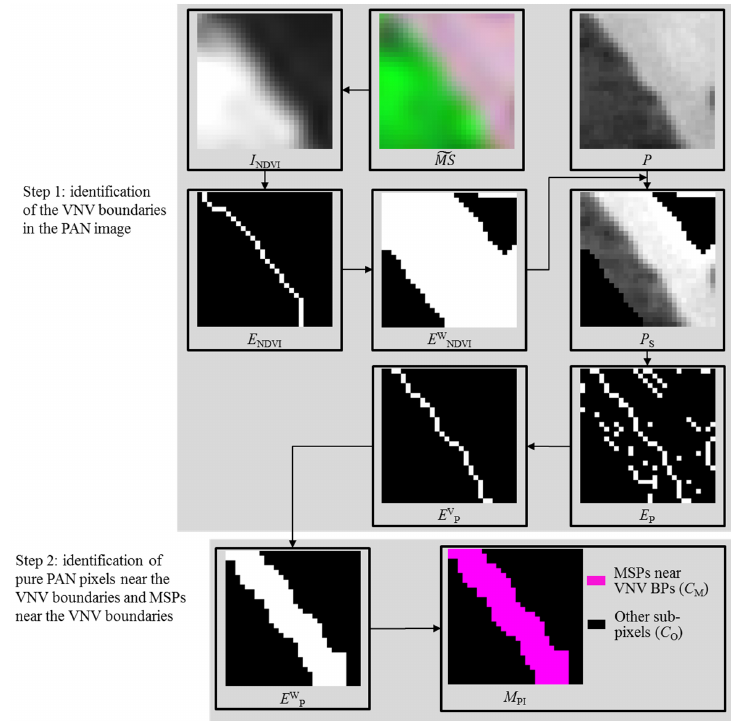
Figure 2. Scheme for the identification of MS sub-pixels (MSPs) near VNV boundaries.